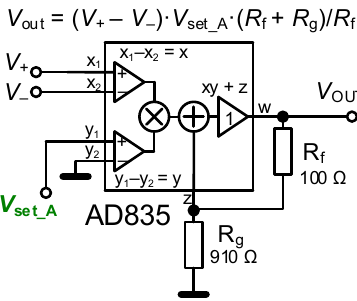
Figure 4. Principle of VGA operation and gain setting.